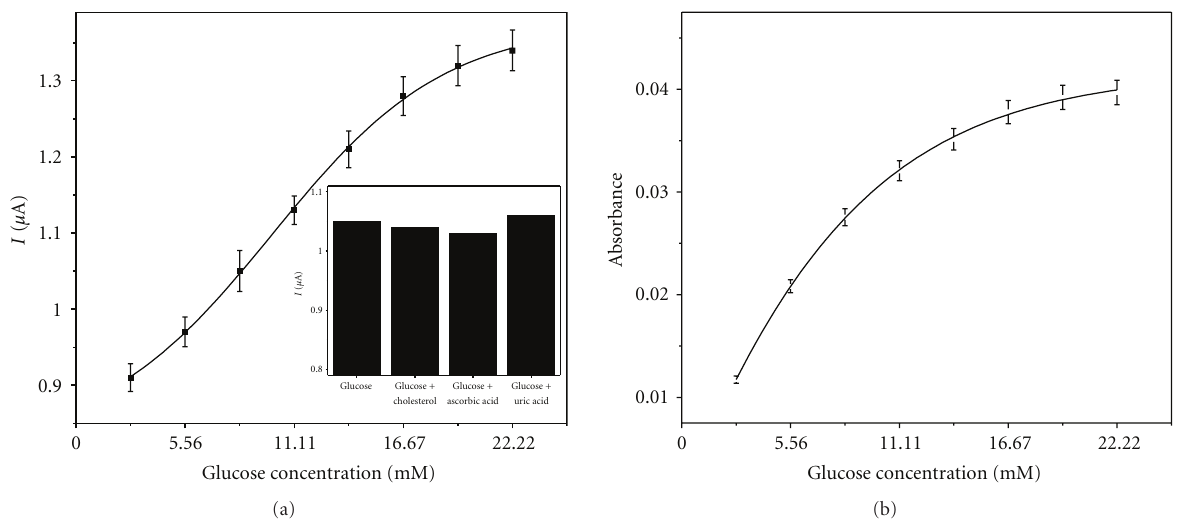
Figure 6: (a) Response curve: variation of current at a fixed potential of − 0.23 V for GOx/ZnO-MB/ITO bio-electrode with glucose concentration (inset shows the e ff ect of various interferants on the response of the biosensor), (b) Photometric assay of GOx/ZnO-MB